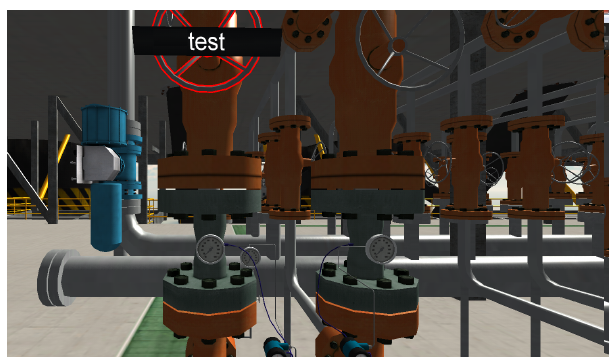
Figure 18. Insertion of tags on valves.